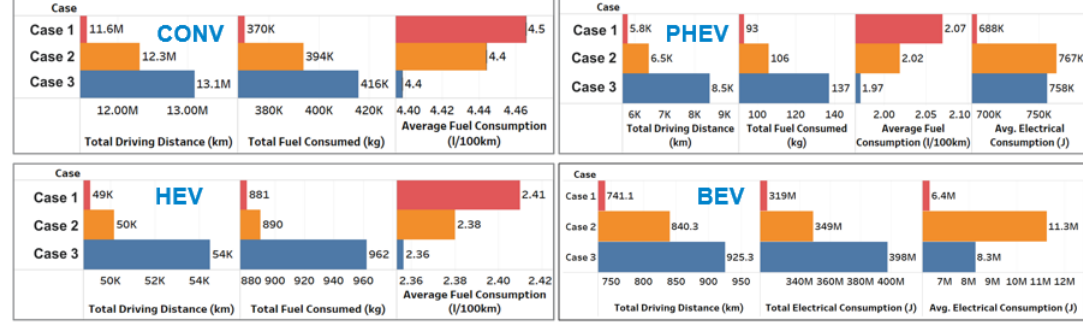
Figure 9. Simulation results summary across vehicle